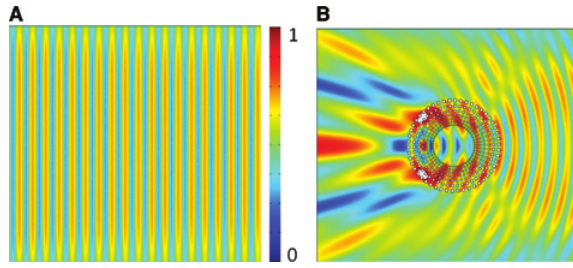
Figure 16: Numerical simulations (COMSOL MULTIPHYSICS) of a flexural plane wave propagating at 5 Hz in a 5 m thick homogeneous plate of clay (A) and same (B) with a distribution of boreholes as in Figure 15B. Magnitude of out-of-plane displacement field (normalized with respect to source) is shown and its enhancement in the corridors of the cloak should be noted. The two white spots in (B) correspond to maxima of field magnitude in the range [1, 1.5] outside the color